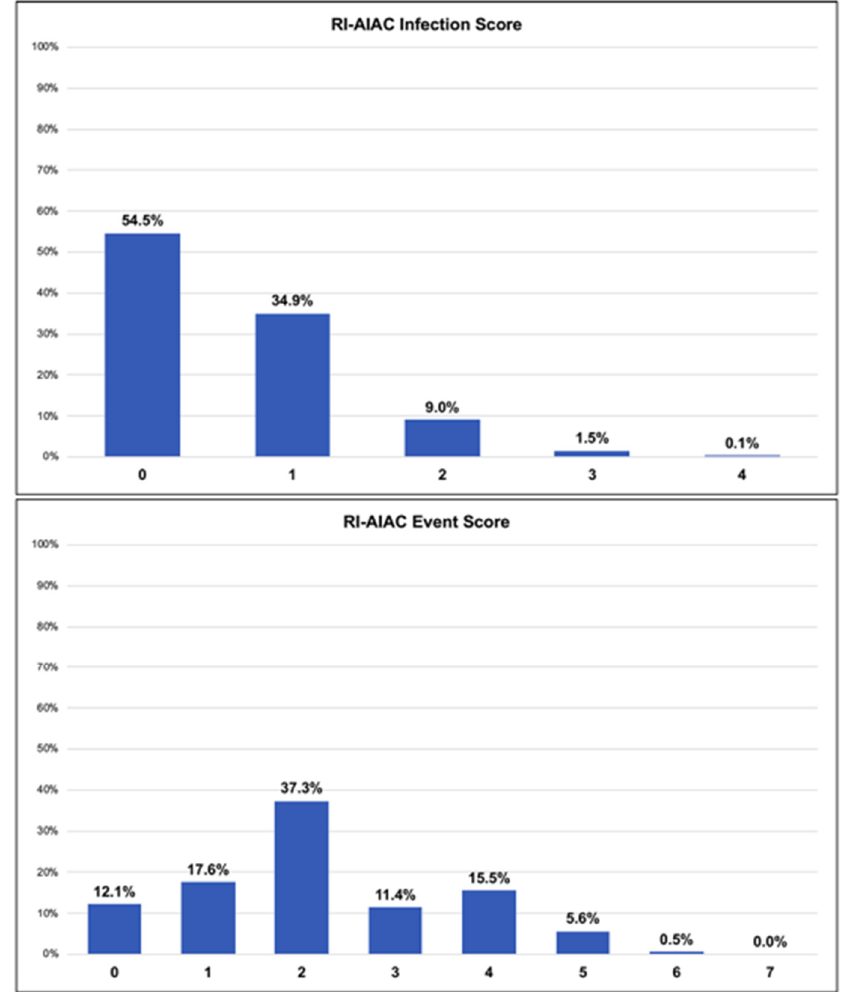
Figure 3. RI-AIAC scores distribution; (Upper Figure RI-AIAC Infection Score; Lower Figure) RI- AIAC Event Score; RI-AIAC = Ricerca sulle Infezioni Associate a ImpiAnto o sostituzione di CIED.